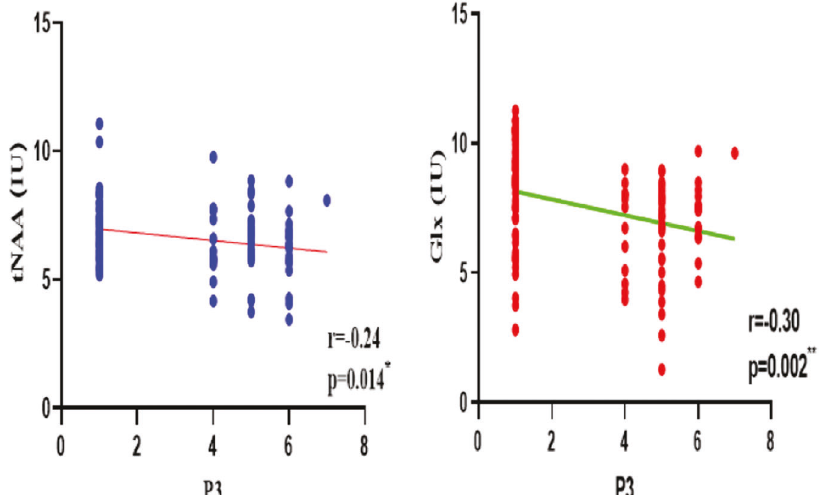
Fig. 3 The relationship between the abnormality of brain metabolites in medial prefrontal cortex (mPFC) and the severity of persistent auditory verbal hallucination (pAVH) in patients with schizophrenia. The relationship between the severity of pAVH (measured by the P3 hallucination item in PANSS) and the level of tNAA ( r = − 0.24, p = 0.014) and Glx ( r = − 0.30, p = 0.002) in mPFC. IU institutional units. * p < 0.05, ** p < 0.01.